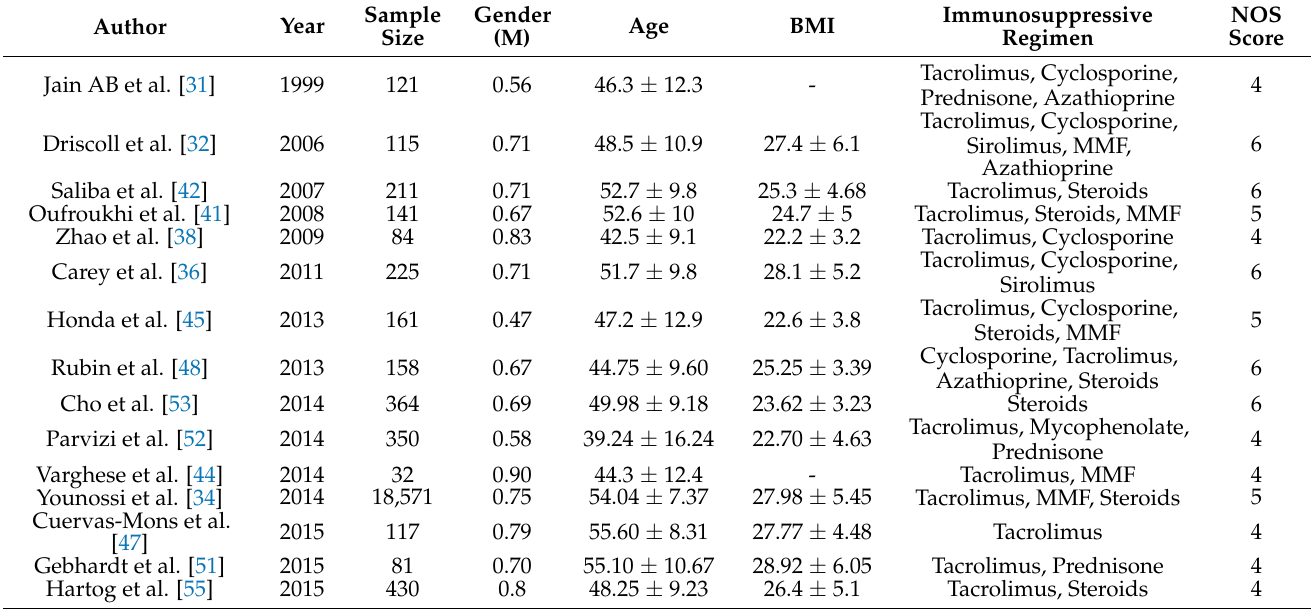
Figure 1. Flow chart of systematic literature search and screening for incidence of New onset diabetes after liver transplantation. Table 1. Summary of Included